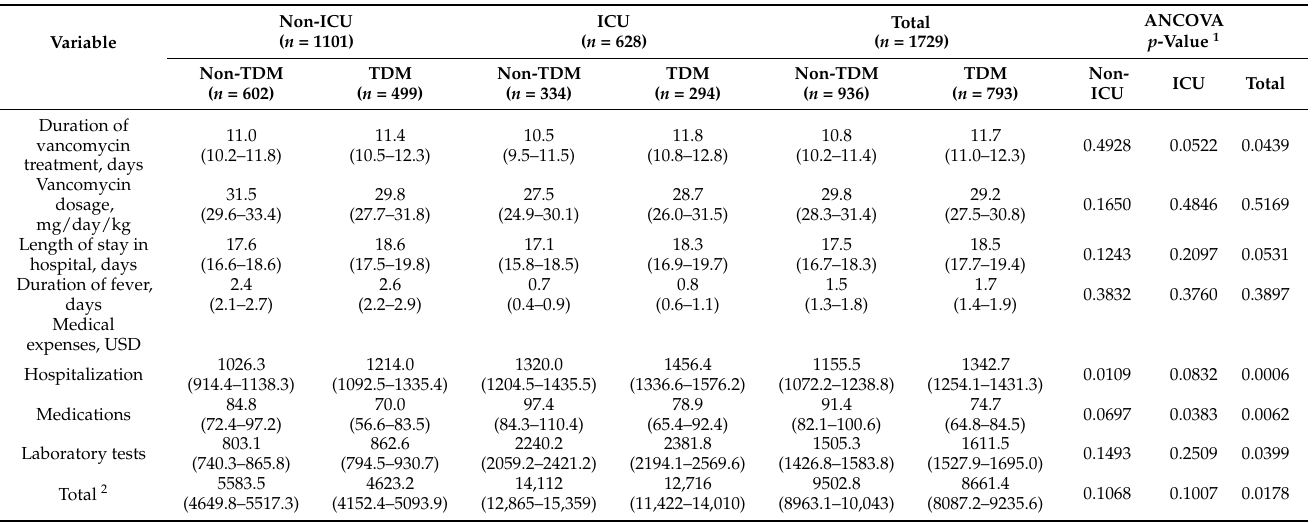
Table 4. Continuous clinical outcomes and medical expenses by ICU admission and TDM group: multivariate